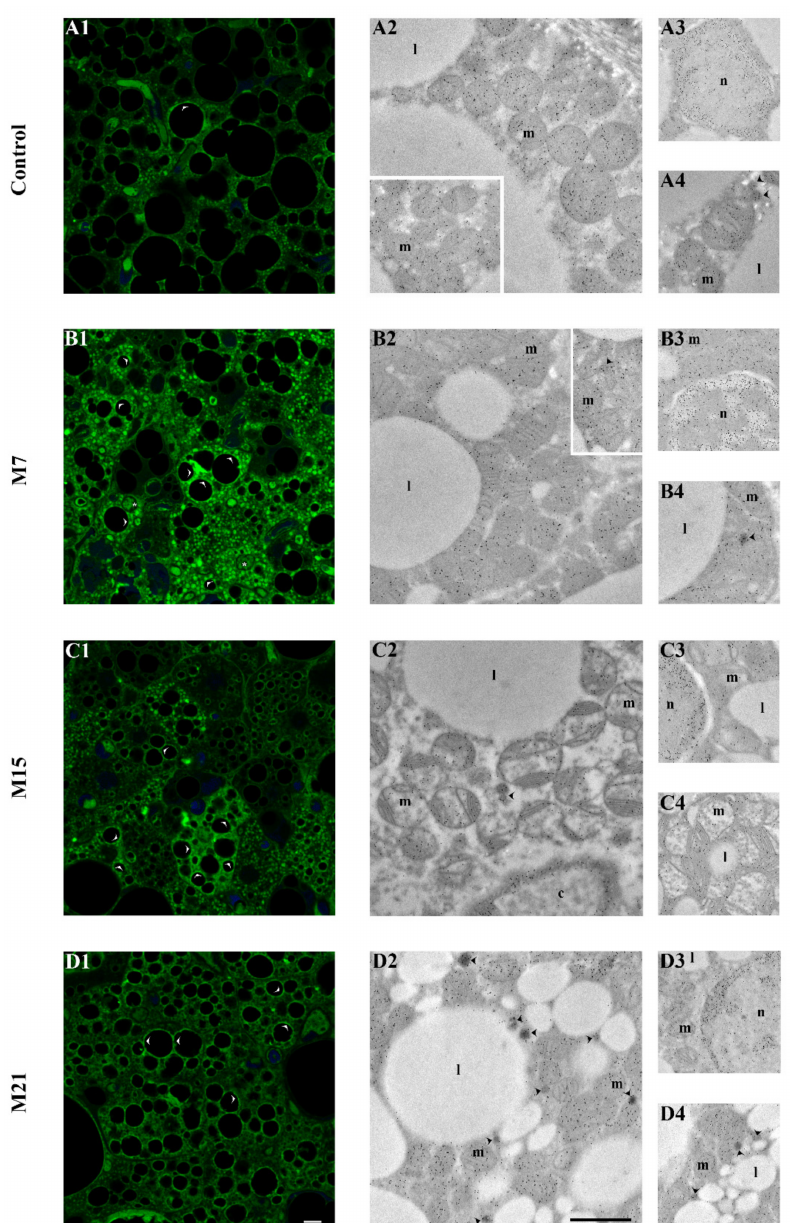
Figure 7. Immunofluorescent and immunogold labeling of 4-hydroxynonenal (4-HNE) modified pro- teins in rat brown adipose tissue of control ( A1 – A4 ) and hypothyroid groups M7 ( B1 – B4 ), M15 ( C1 – C4 ), and M21 ( D1 – D4 ), respectively. l, lipid body; m, mitochondria; n, nuclei; c, blood capillary; black arrowhead, peroxisomes; white arrowhead, immunopositive reaction around lipid bodies (confocal mi- croscopy); (*) white star, immunopositive nuclei (confocal microscopy). Scale bars: confocal microscopy 5 µ m on x2.5 zoom, transmission electron microscopy 1 µ